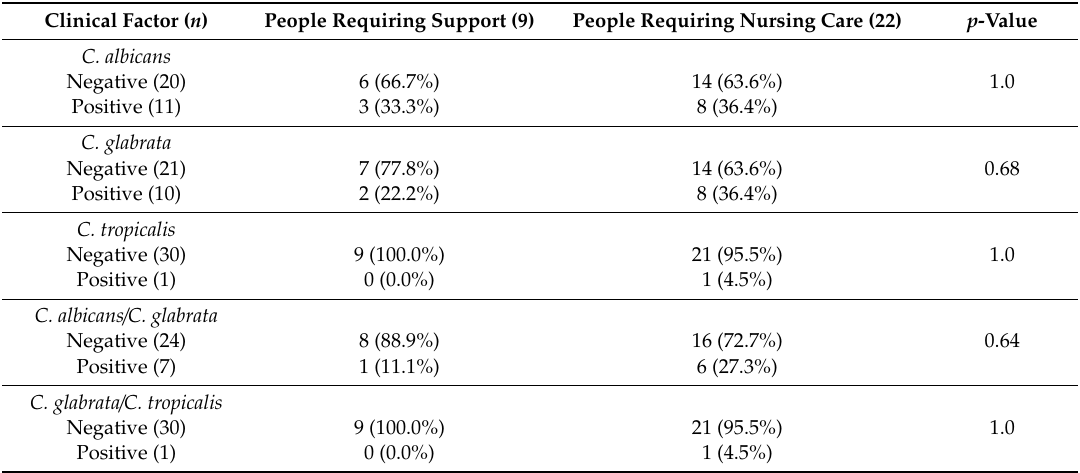
Table 4. Rates of oral Candida in older people who required long-term support or nursing